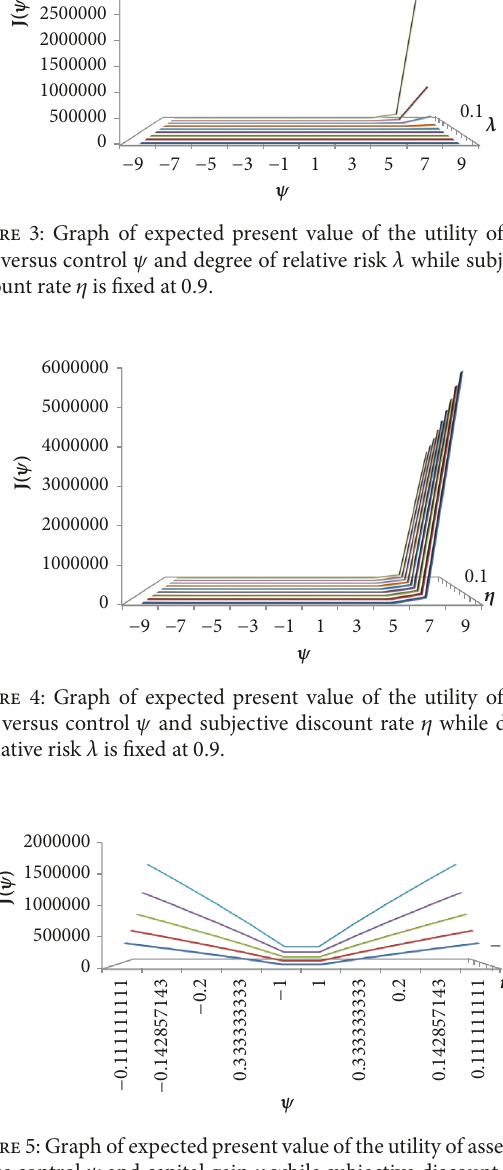
Figure 5: Graph of expected present value of the utility of asset 𝐽(𝜓) versus control 𝜓 and capital gain 𝜅 while subjective discount rate 𝜂 and degree of relative risk 𝜆 are fixed at 0.1 and 0.9 , respectively.